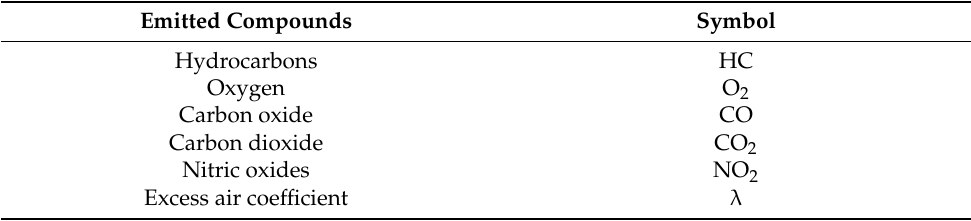
Table 2. The emitted compounds that were